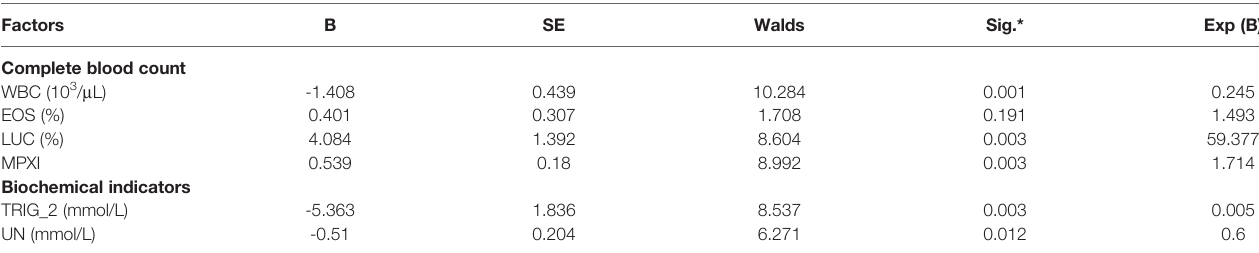
TABLE 1 | Multivariate regression analyses based on complete blood count and biochemical indicators for determining damp-heat related factors. Factors B SE